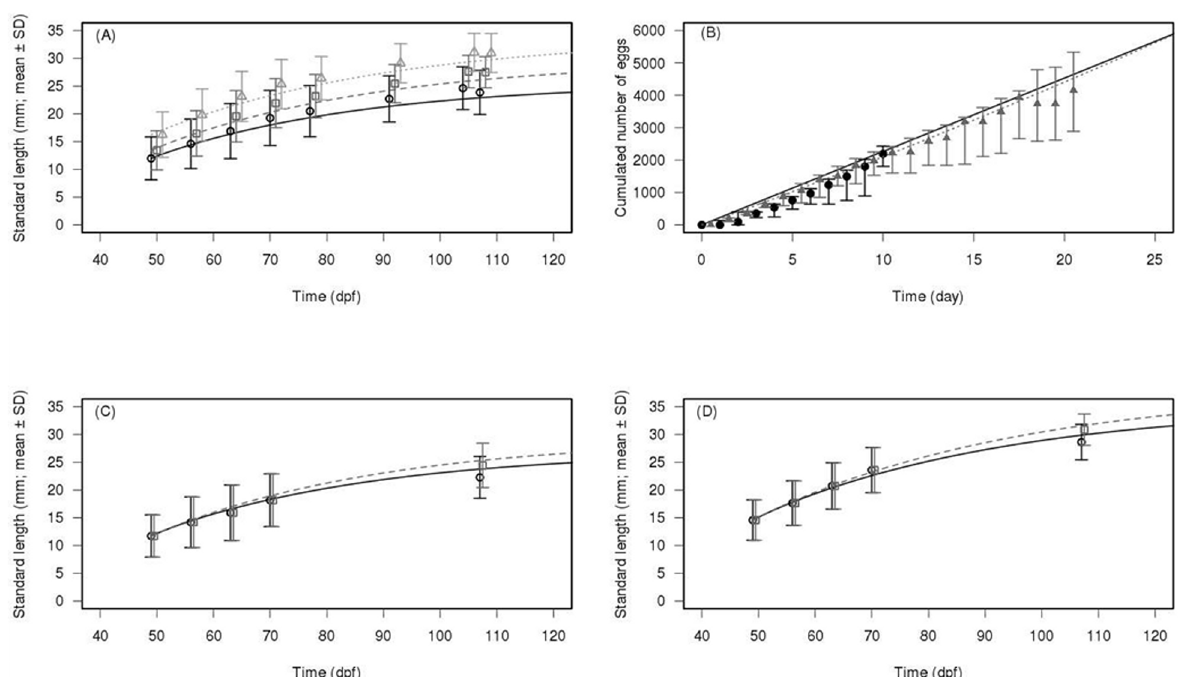
Fig 5. DEB model simulations compared to the experimental data produced in this study. All lengths are presented as standard length (mm). Points represent observations (mean ± SD for length data), lines represent model predictions. (A) Length data, experimental temperature (T exp ) of 27°C, estimated ingestion level ( f ) of 0.70 (circles), 0.81 (squares), and 0.93 (triangles). (B) Median of the cumulated number of eggs, T exp = 26°C, f = 0.48 (points) and T exp = 29°C, f = 0.93 (triangles); Error bars represent the first and third quartiles (C) Model predictions against observed length data for males (black circles and solid line) and females (grey squares and dashed line). T exp = 27°C, f = 0.76. (D) Model predictions against observed length data for males (black circles and solid line) and females (grey squares and dashed line). T exp = 27°C, f = 0.99.